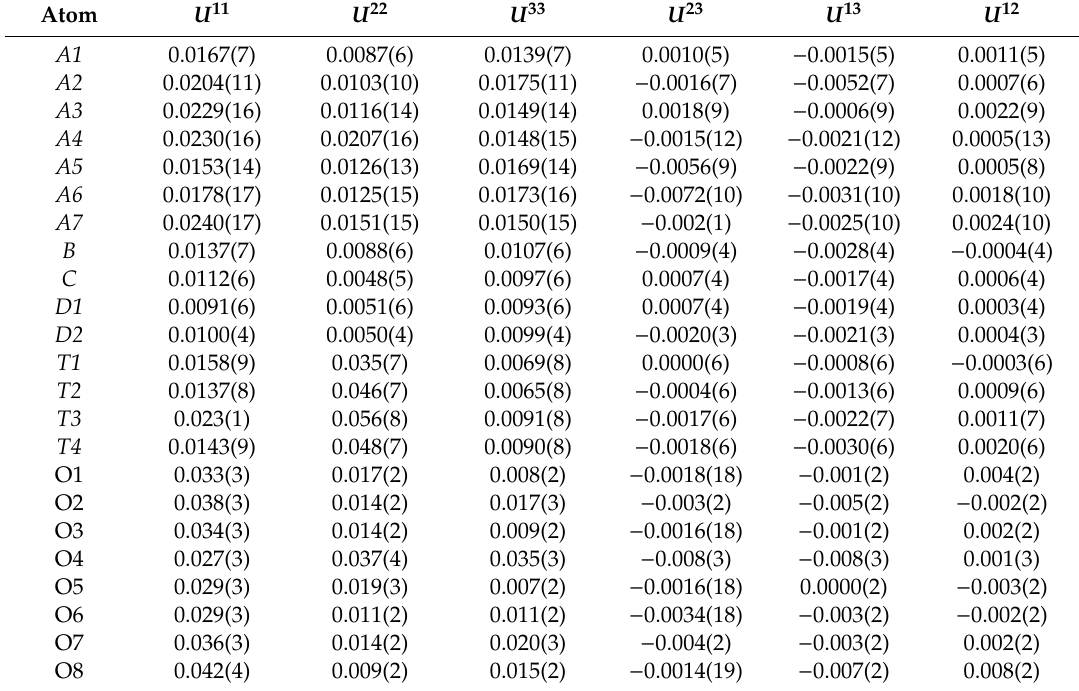
Table 6. Anisotropic displacement parameters (Å 2 ) for